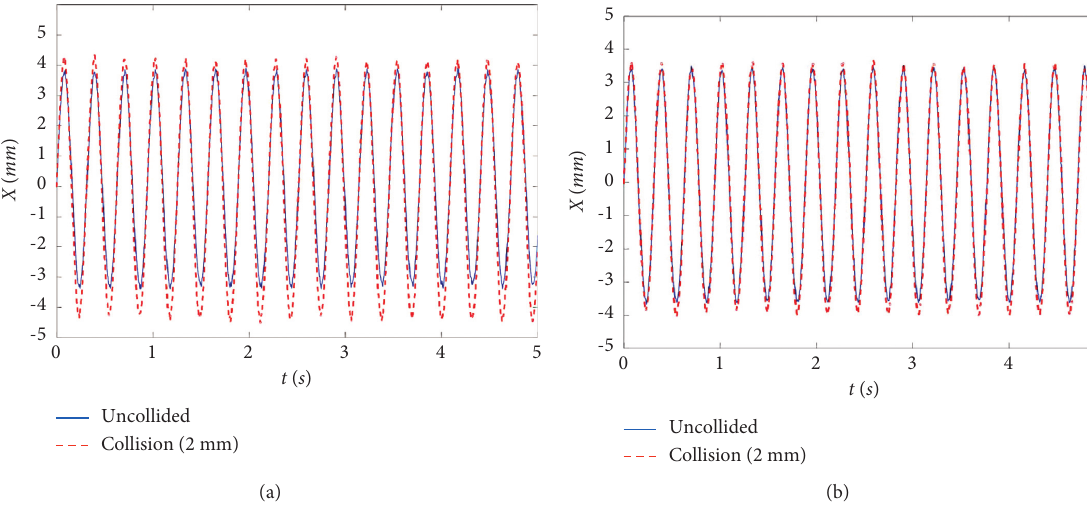
Figure 11: Relative displacement histories of the top and third story of structure A under pounding and nonpounding loading. (a) Histories of the relative displacement of the top story. (b) Histories of the relative displacement of the third story.